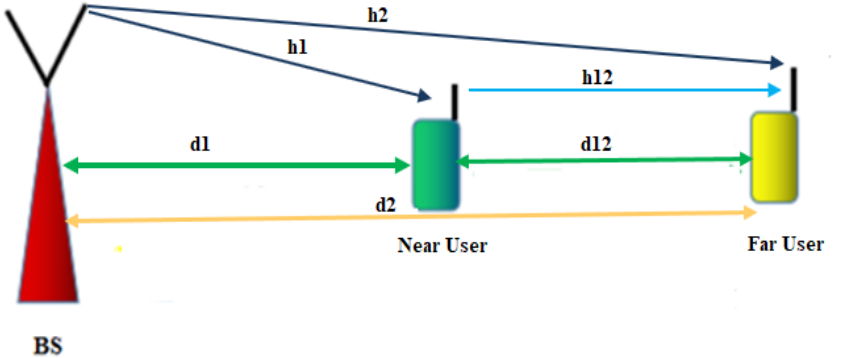
Figure 1. Downlink transmission for the NOMA network.